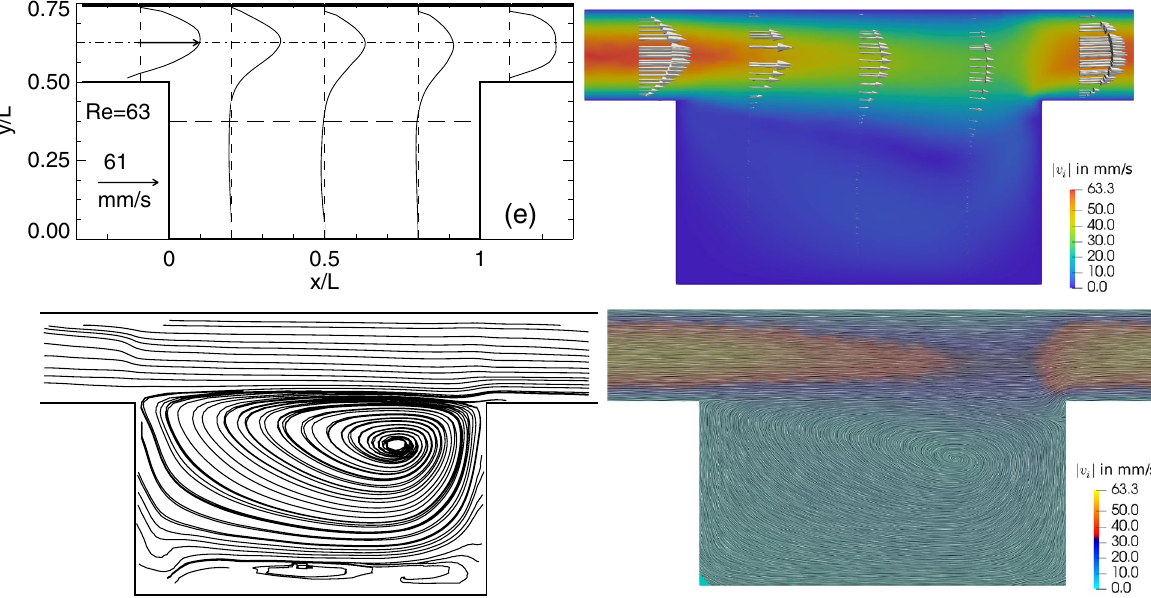
Fig. 10 Comparison of measurement and calculations: Case e) PIV left column and CFD right column. Selected velocity profiles (top row) and streamlines (bottom row) are